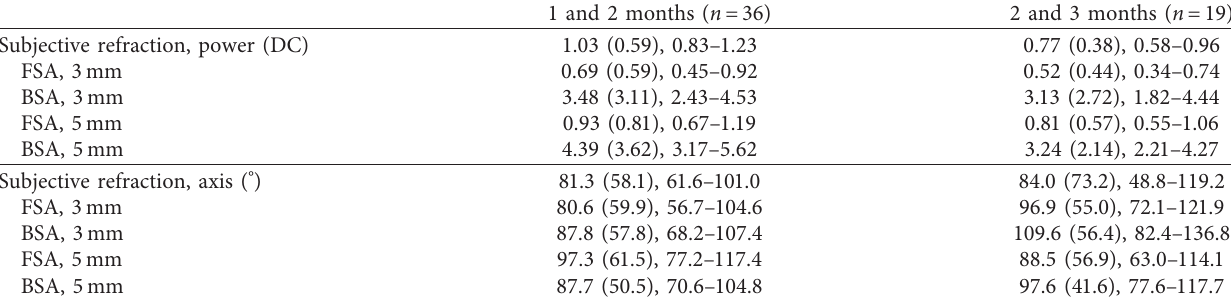
Table 2: Calculated change in the astigmatic power (DC, diopters) and axis ( ° ) with reference to the results obtained during routine subjective refraction and Orbscan II analysis of the corneal back surface (CBS) over 3 and 5mm central zones.